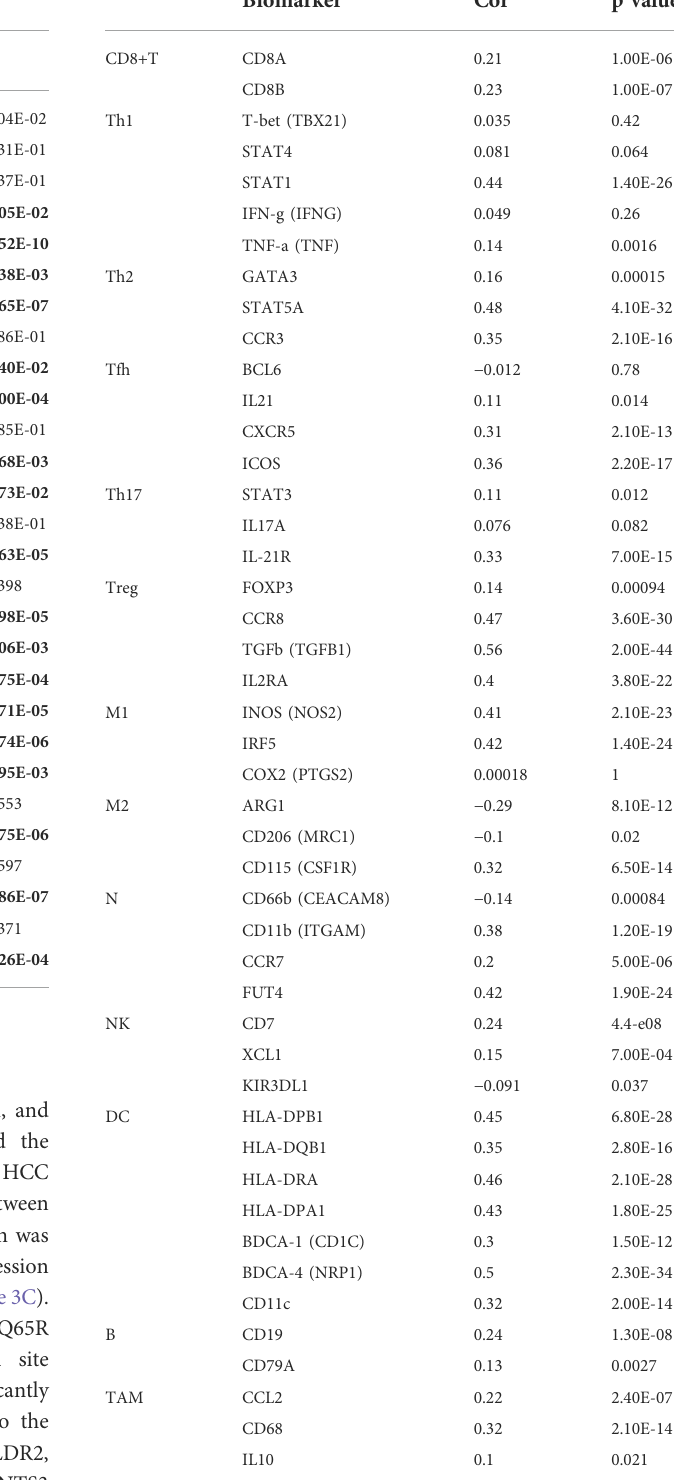
TABLE 2 The correlation between RAB6B expression and tumor lymphocyte in fi ltration in HCC (TISIDB).